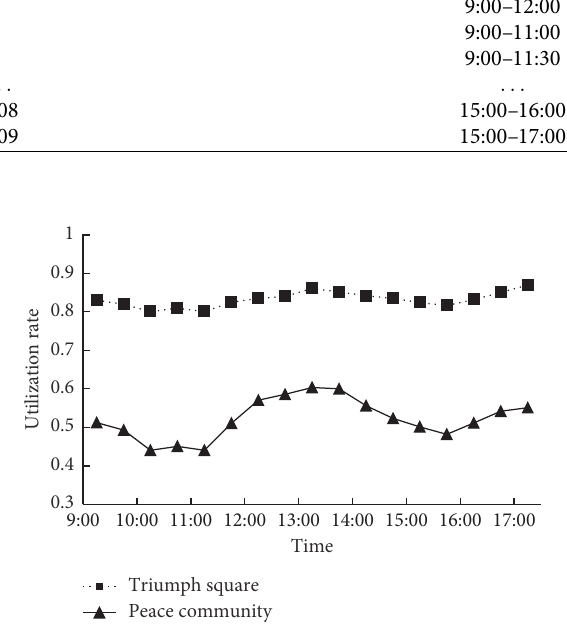
Figure 3: The changes of utilization rate between residential